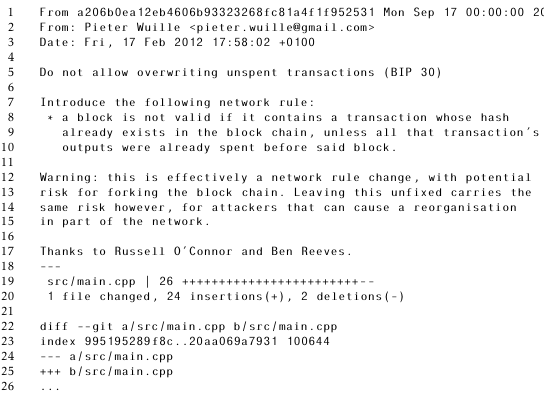
Figure 1. An example of commit message